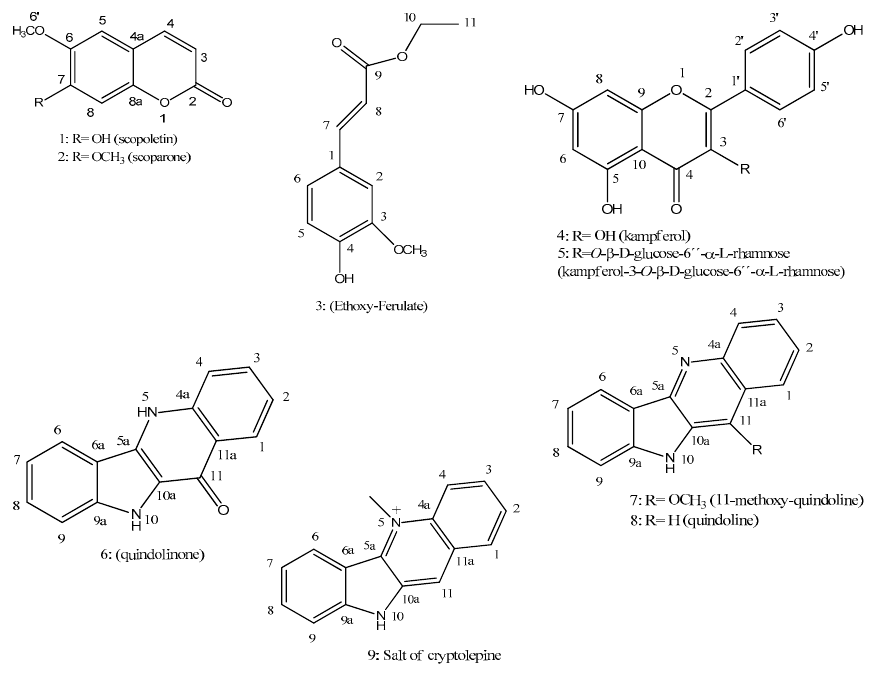
Figure 1. Structure of compounds isolated from S. rhombifolia (Malvaceae). Table 1. NMR data ( 1 H, 13 C, HMQC, HMBC and NOESY) of compound 7 ( δ , DMSO- d 6 , 500 and 125 MHz).